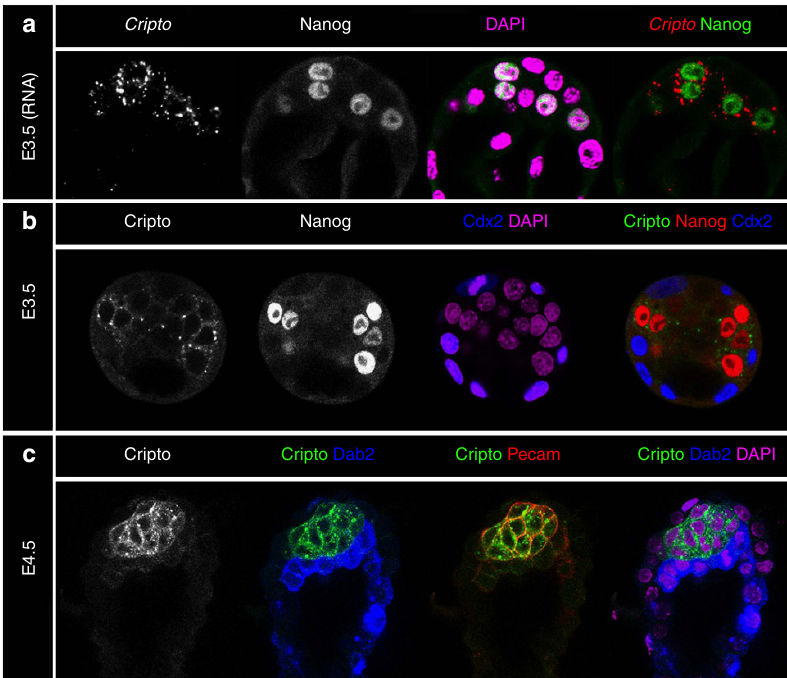
Figure 1 | Cripto is specifically expressed in EPI cells. ( a ) FISH and ( b ) immunofluorescence analyses of Cripto expression at E3.5. Both Cripto RNA and protein are present in Nanog-expressing cells. ( c ) By E4.5, Cripto remains expressed in the EPI, labelled by Pecam1 and is absent from the PrE revealed by Disabled 2 (Dab2) and the